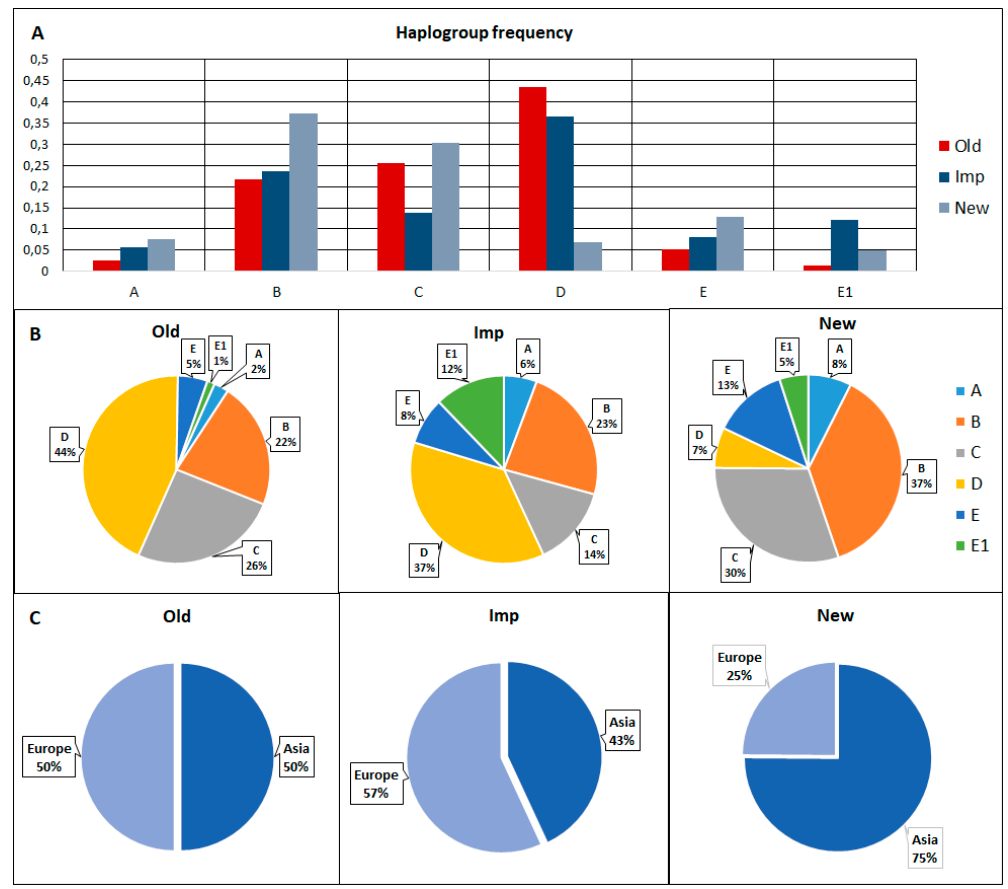
Figure 3. Frequencies of mtDNA haplogroups in Old, Imp, and New pigs ( A —frequency distribution of haplogroups A, B, C, D, E and E1 in pigs of groups Old, Imp and New; B —frequency distribution of haplogroups A, B, C, D, E and E1 in each group; C —frequency distribution of haplogroups Asia (A, B, C) and Europe (D, E, E1) in pigs of groups Old, Imp, and New). The distribution of haplogroups also differed between the Old, Imp, and New groups. In the Old group, haplotype D had the highest frequency, and, in general, the distribution for Asian and European haplotypes was 50/50. European haplogroups prevailed in the Imp group ( n = 70; 56.9%) and haplogroup D had the highest frequency. Asian haplogroups prevailed in the New group ( n = 151; 75%) and group B haplotypes had the highest frequency.